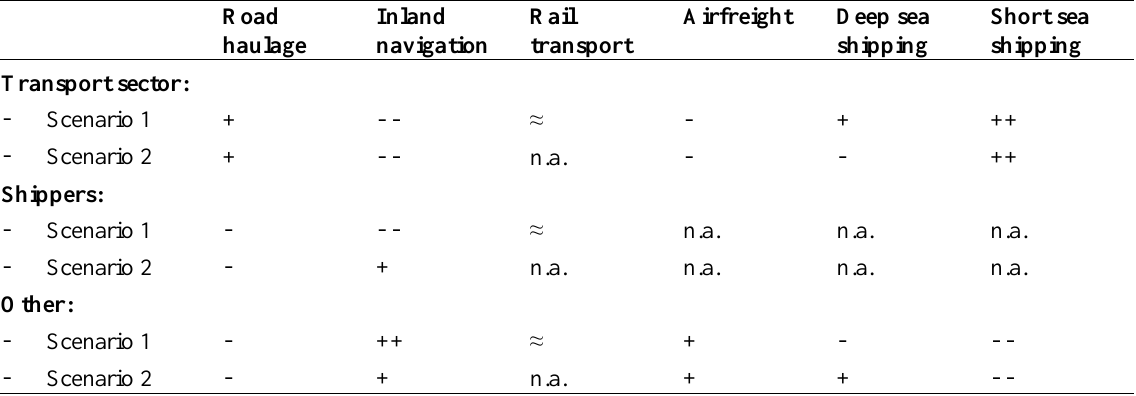
Table 7. Differences in experts’ expectations regarding the impact of the two policy scenarios on rates, according to professional background Road Inland haulage